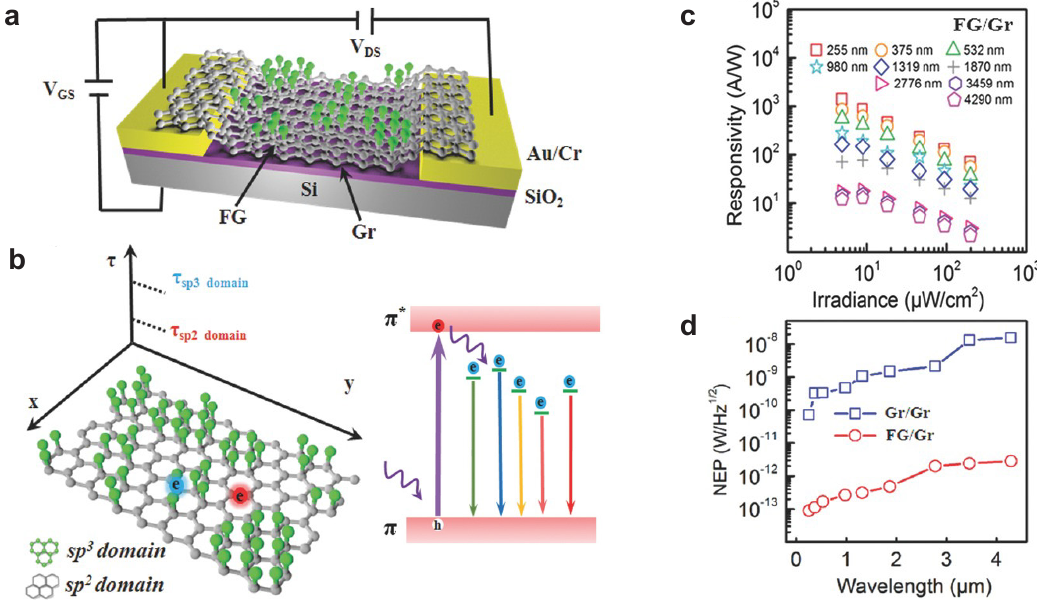
Figure 5. Fluorographene (FG) photodetectors. ( a ) device schematic of a FG/graphene PD; ( b ) domain structure of partially-fluorinated graphene and corresponding lifetimes of photoexcited charges (left). Trapping and relaxation schematic in FG responsible for the observed photo-response; ( c ) responsivity as a function of incident power density for multiple wavelengths and ( d ) comparison of noise equivalent power (NEP) as a function of incident wavelength for a graphene/graphene and a FG/graphene device. Reprinted with permission from Du et al. [80], Adv. Mater. 29, 1700463. Copyright: 2017 John Wiley and